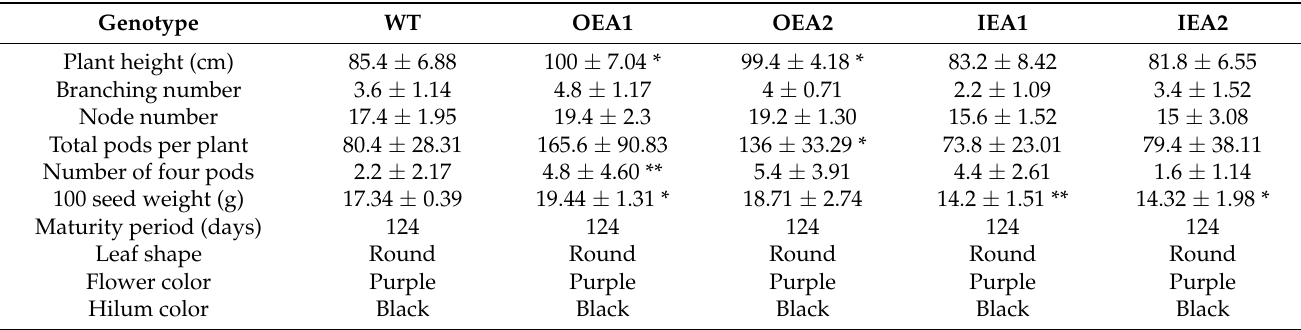
Table 2. Agronomic traits analysis of the transgenic